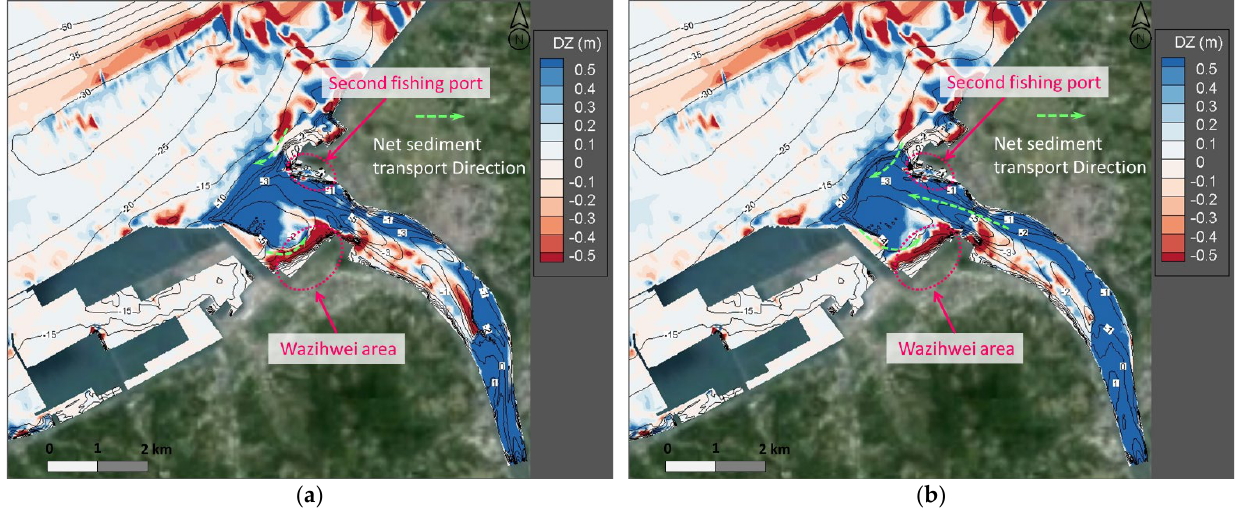
Figure 13. Changes in topographical erosion and deposition in the Tamsui River estuary after the end of monsoon and typhoon seasons in the fourth year (DZ = bed change, the contour line is bed elevation. The unit is meters for both). ( a ) At the end of monsoon season of the fourth year. ( b ) At the end of monsoon season and typhoon flood period of the fourth year.